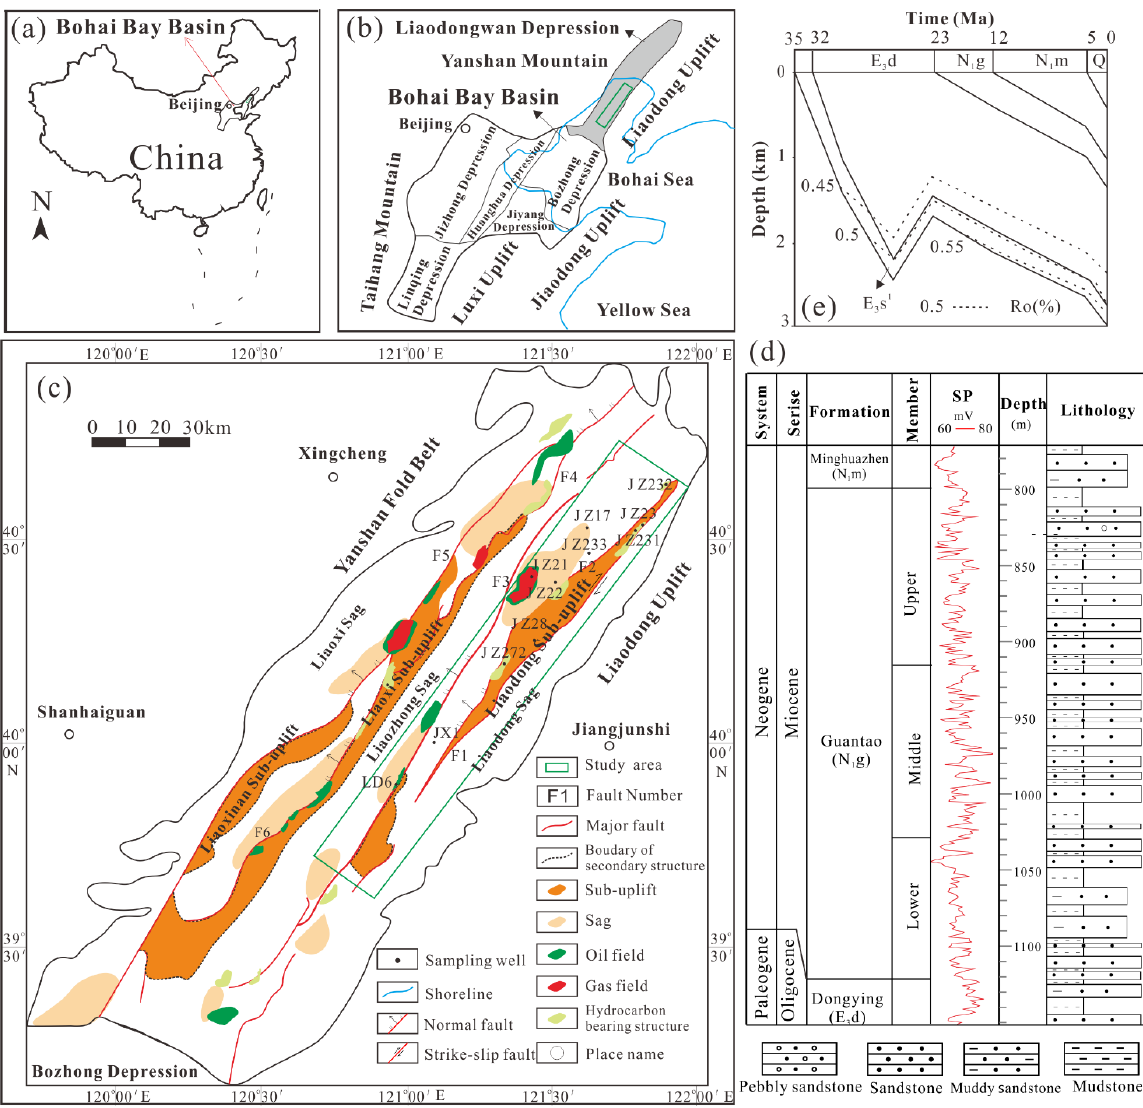
Figure 1. ( a ) Sketch map showing the location of the Bohai Bay Basin; ( b ) location of the Liaodongwan Depression in the Bohai Bay Basin; ( c ) tectonic unit divisions of the Liaodong Depression and location of sampling wells (modified from Zhong, 2017 [28]); ( d ) composite column of the Guantao Formation (well JZ27); ( e ) burial and thermal history of the Neogene in the study area (modified from Zhang, 2018 [37]), SP: curve of natural potential.